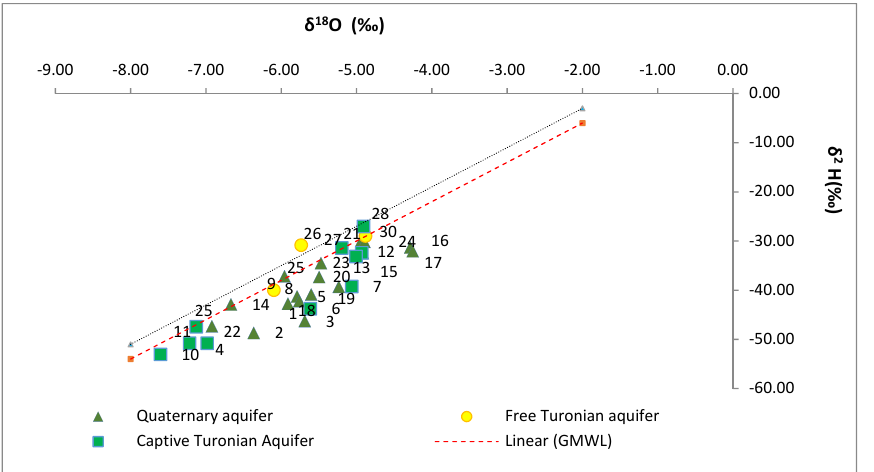
Figure 8. Plot of the levels of δ 18 O versus δ 2 H;. The samples are sorted according by geographical and system distribution.